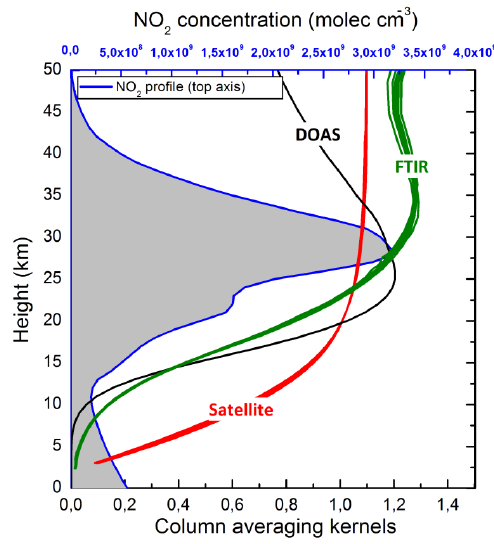
Figure 1. Typical averaging kernels of DOAS (black line), FTIR (green line) and satellite (red line) instruments for the diurnal period of measurements. The shaded area represents a NO 2 vertical profile (top axis) over Izaña obtained from the American Standard Atmo- sphere (US Standard Atmosphere, 1976, US Government Printing Office, Washington, DC, 1976) for the